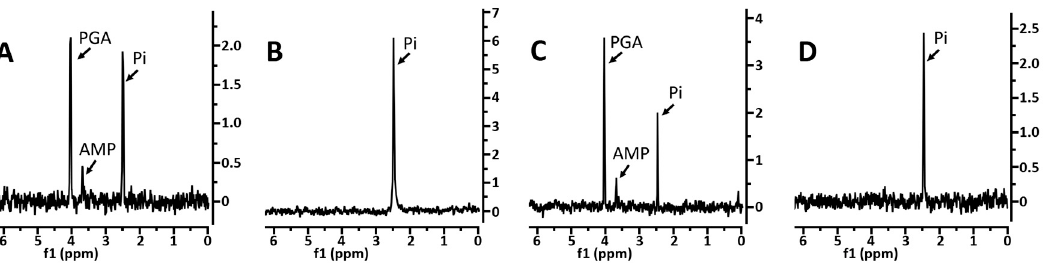
Figure 1. ( A – D ) Levels of 3PGA, inorganic phosphate (Pi), and AMP in dormant and germinated spores of various strains as determined by 31 P-NMR. The spores of various strains, either dormant or germinated, were prepared, extracted, processed, and analyzed by 31 P-NMR, as described in the Methods section. Extracts analyzed: ( A ) PS533 dormant (1.1 × 10 10 spores); ( B ) PS3406 dormant (1.9 × 10 10 spores); ( C ) FB113 dormant (1.5 × 10 10 spores), and ( D ) FB113 germinated (4 × 10 9 spores); the identities of all major peaks are labeled; this experiment was carried out twice with nearly identical results.